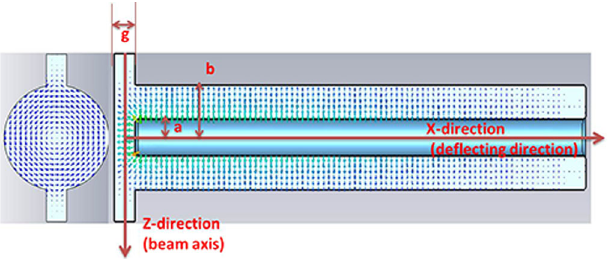
FIG. 2. Deflecting QWR cavity model of the fundamental mode (47.63 MHz) with the left view section showing the magnetic field distribution (left) and the front view section for the electric field distribution